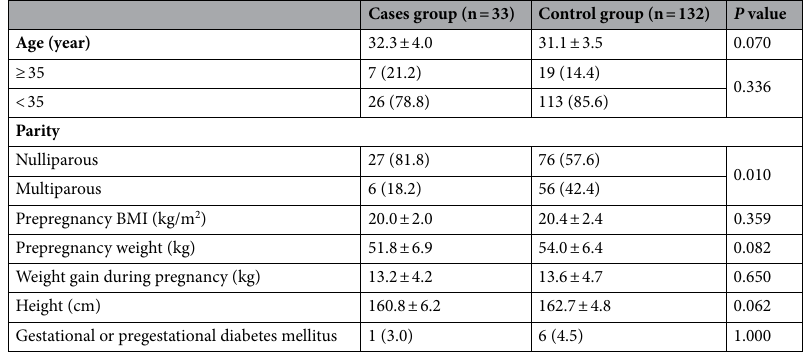
Table 1. Maternal characteristics. Data expressed as mean ± standard deviation or number (%). BMI body mass